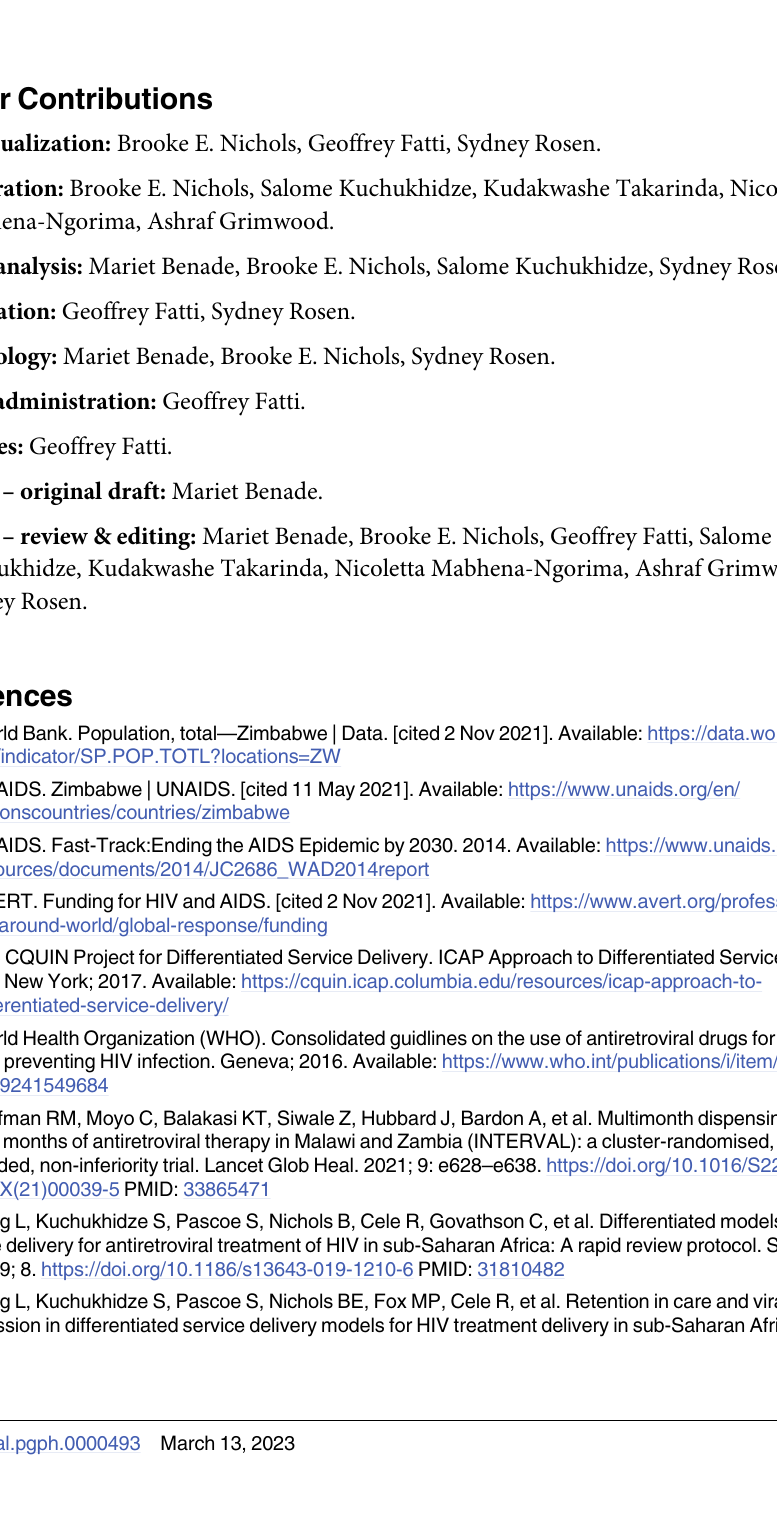
S1 Table. Baseline characteristics of